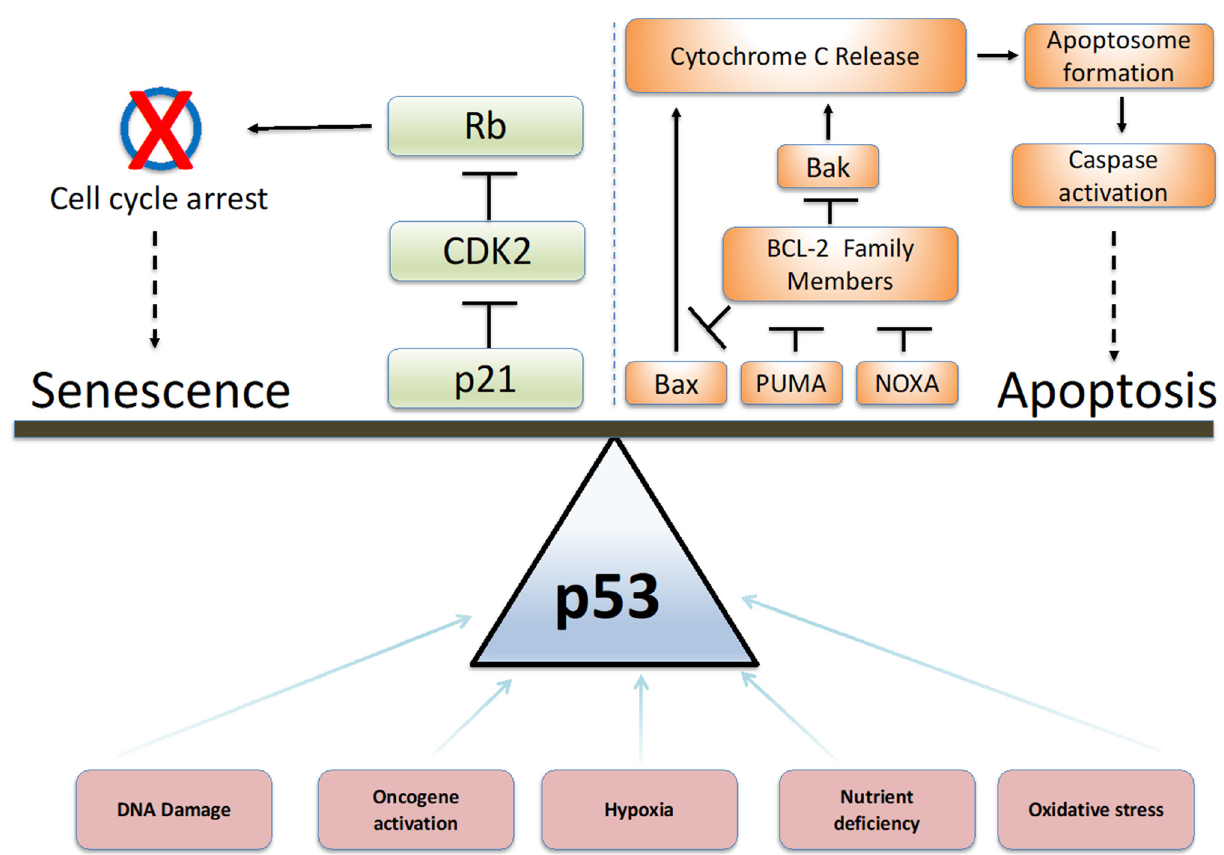
Figure 1. p53 determines cell fate outcomes. In response to different environmental stresses p53 dependent signalling is able to shift the balance between senescence and apoptosis.